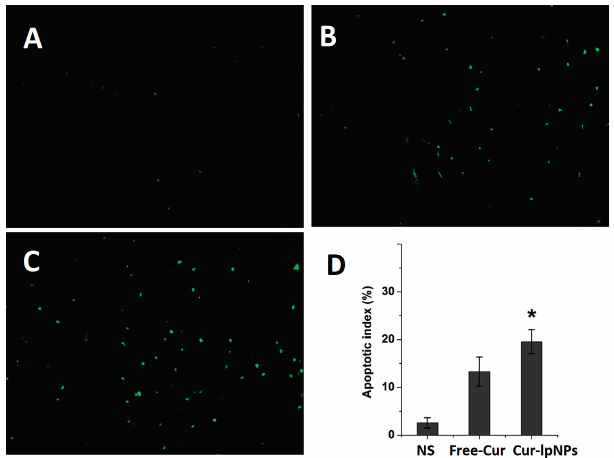
Figure 7. Terminal deoxynucleotidyl transferase-mediated nick-end labeling (TUNEL) immunofluorescent staining of tumors in each group. Representative TUNEL immunofluorescent images (magnification: 40×) of normal saline(NS) ( A ); free Cur ( B ); and Cur–lpNPs ( C ) group; and mean apoptotic index in each group ( D ) ( * p < 0.05).